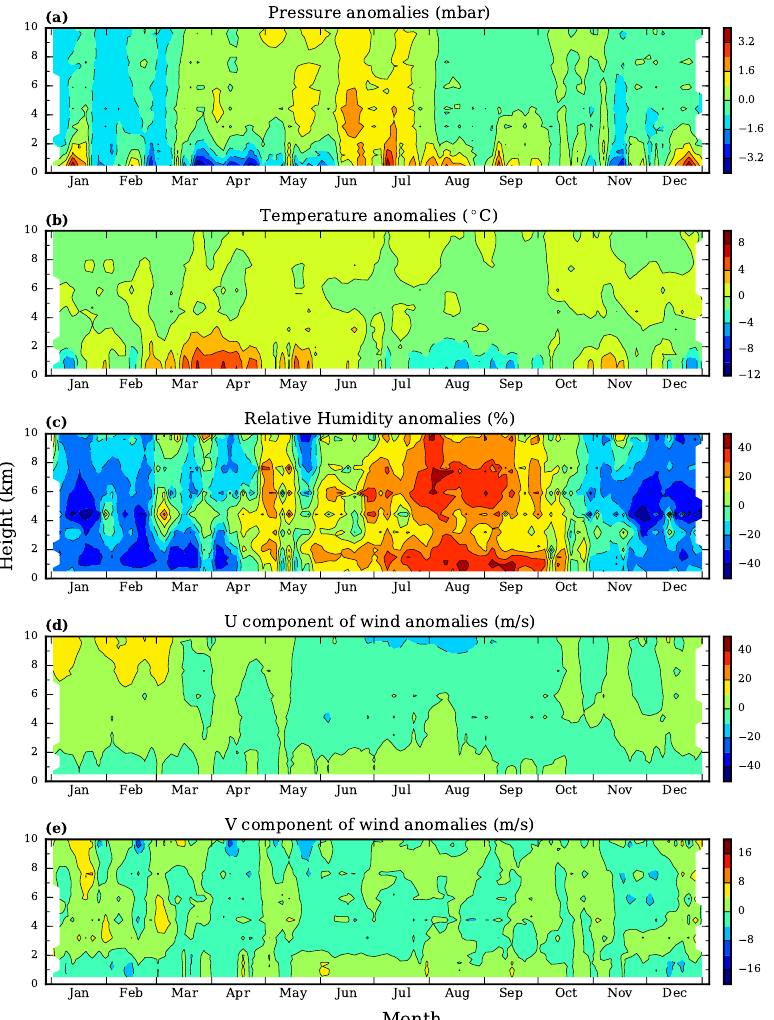
Figure 5. Differences between the mean of atmospheric vertical parameters extracted from European Center for Medium-Range Weather Forecasts (ECMWF) databases and ( a ) pressure, ( b ) temperature, ( c ) relative humidity, ( d ) U component of wind and ( e ) V component of wind in Maroua in